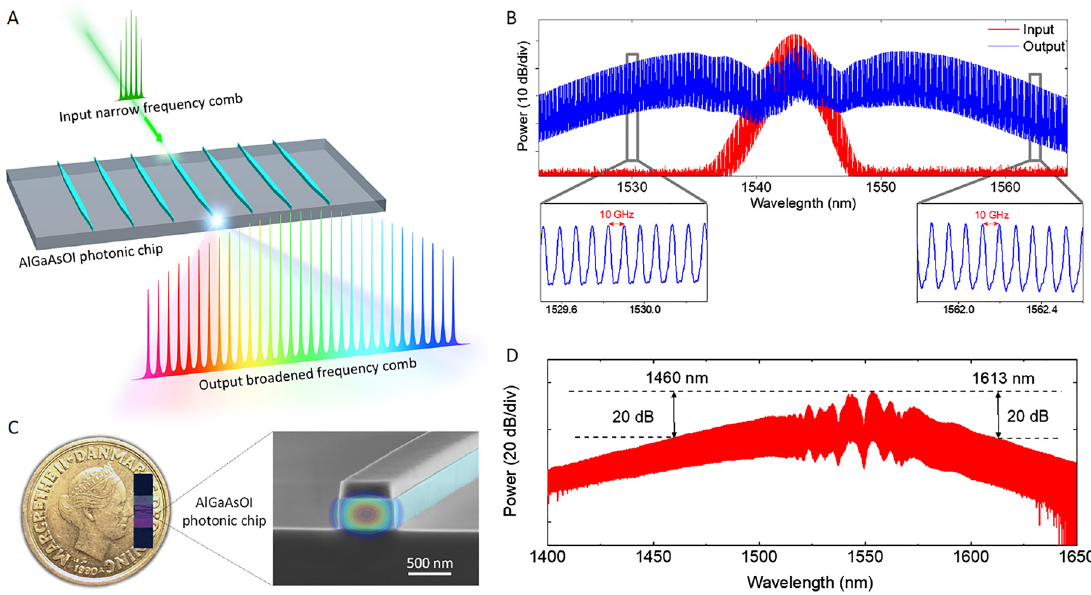
Figure 7: (A) Schematic of spectral broadening of frequency comb on an AlGaAsOI nano-waveguide. (B) Optical spectra of the 10-GHz 1.5-ps seed pulses and generated broadband frequency comb. The input frequency comb (20-dB bandwidth of 6.4 nm) is spectrally broadened to a 20-dB bandwidth of ∼ 44 nm, covering more than the telecom C band. The comb lines are equidistantly spaced by 10 GHz, same as the repetitionrateoftheseedpulses.(C)TheAlGaAsOIphotonicchipissmallerthanacoin,butcanaccommodatehundredsofnano-waveguides. The SEM image shows the cross section of the nano-waveguide with cross-section dimensions of 280 × 600 nm, indicating strong light con fi nement(arti fi ciallyadded:thesimulated fi elddistributionforthefundamentalTEmode).(D)Opticalspectrumofthegeneratedfrequency comb using 10 GHz fs pulses (FWHM of 230 fs) as the seed. (The fi gures are adapted from the study by Hu et al.